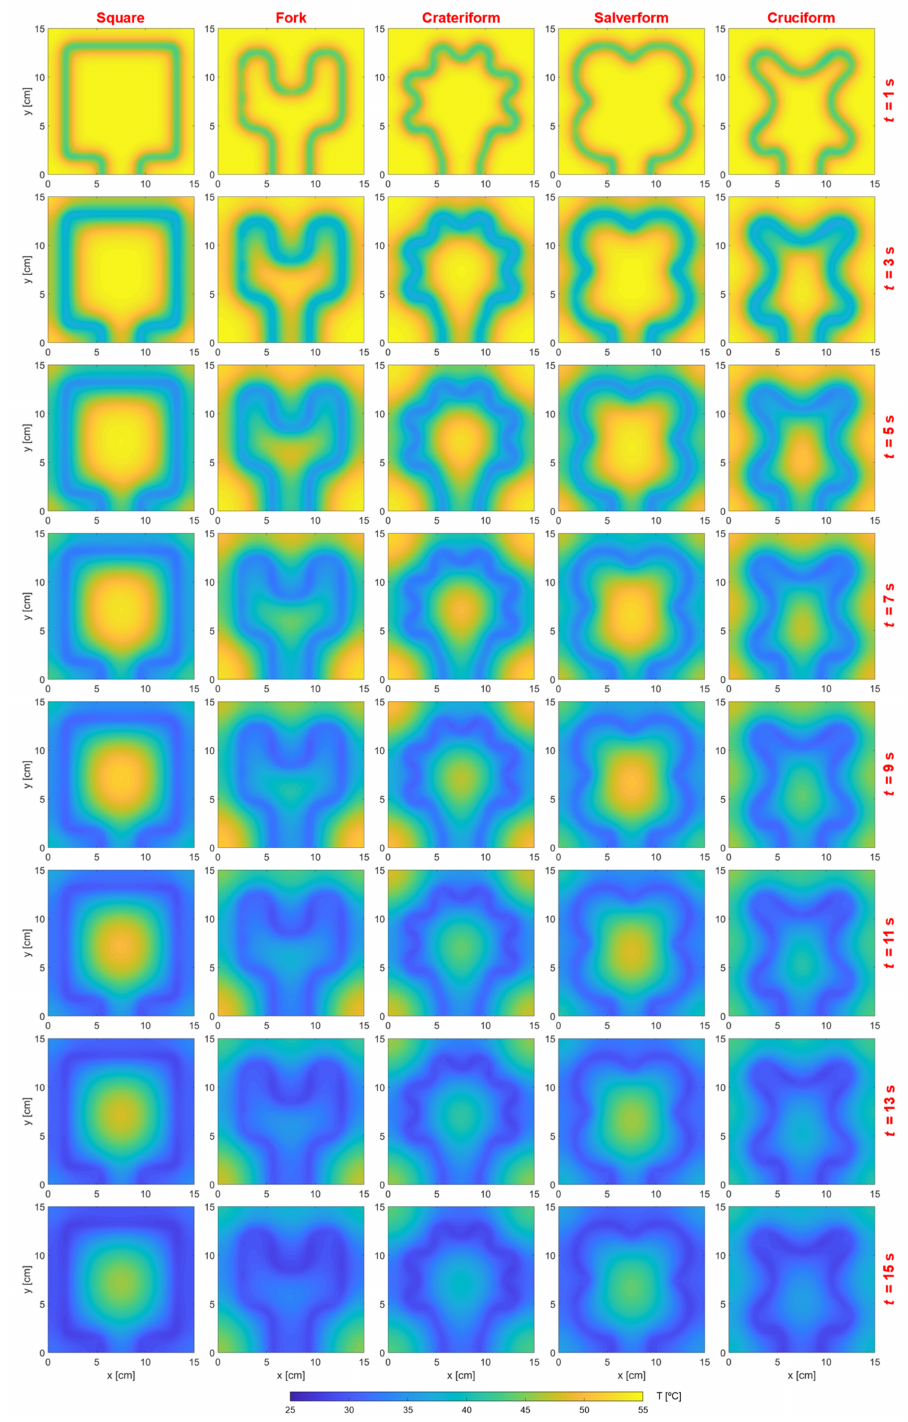
Figure 5. Time evolution of the temperature distribution across the plates for each configuration during the first 15 s of a transient cooling